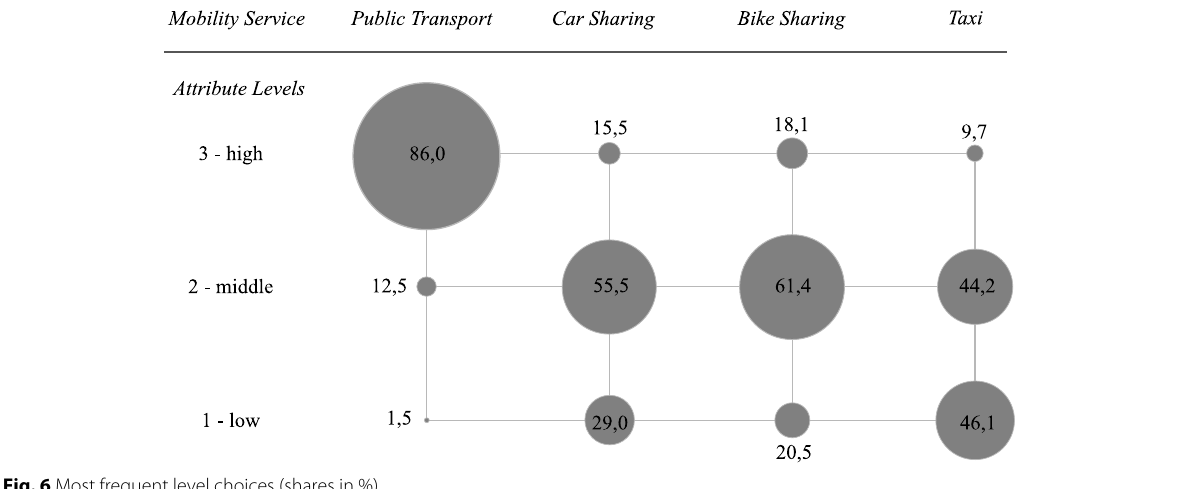
overall evaluation of mobility plans and has the potential to reduce stationary traffic in